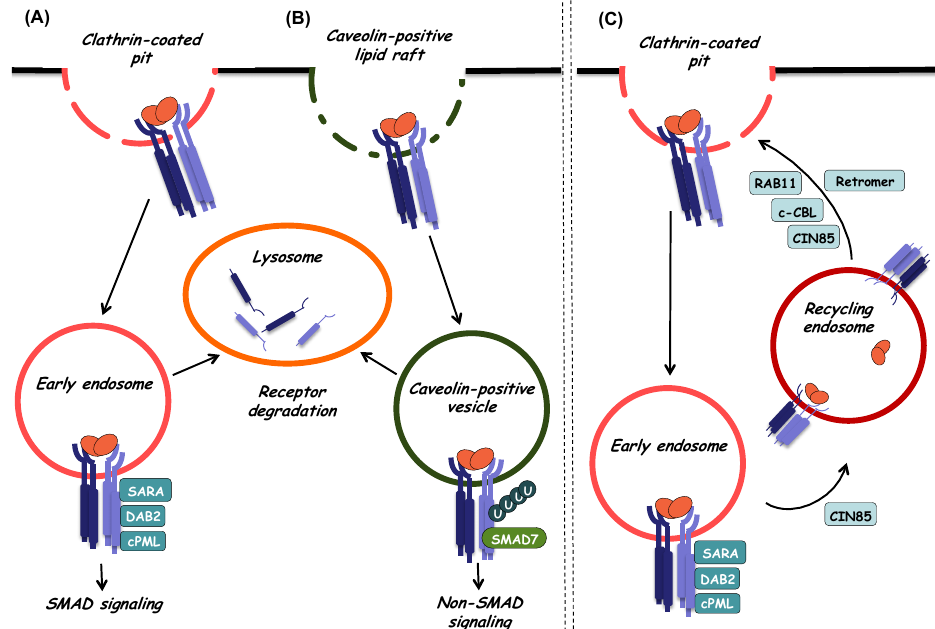
Figure 4. Internalization and intracellular sorting of TGF-β receptors. Endocytosis and intracellular sorting of TGF-β receptors play an important role in the regulation of TGF-β signaling outcome and can be mediated via the two major endocytic pathways. ( A ) SMAD-dependent TGF-β signaling can initiate at the cell surface in clathrin-coated pits. When receptors internalize via clathrin-coated vesicles, they are directed to early endosomes. In these early stages of endocytosis, association of TGF-β receptors with SARA, cPML, and Dab-2 adaptor proteins, leads to the enhancement of TGF-β-induced SMAD activation and subsequent propagation of SMAD-dependent signaling. Internalized TGF-β receptors found in early endosomes can be sorted for degradation. In this case, they enter late endosomes (not shown) and finally reach lysosomes where degradation takes place. ( B ) Internalization of TGF-β receptors can also take place at caveolin-positive lipid raft compartments on the cell membrane, and in this case, internalized receptors enter caveolin-positive vesicles. There, the TGF-β type I receptor preferentially associates with SMAD7, which can control receptor turnover via recruitment of ubiquitin ligases and deubiquitylating enzymes thus regulating ubiquitylation and subsequent lysosomal degradation of receptors. Internalization of TGF-β receptors by lipid raft/caveolar-mediated endocytosis can also promote non-SMAD TGF-β signaling as SMAD7 competes with SMAD2/3 for interaction with the TGF-β type I receptor. ( C ) Once internalized via clathrin-coated pits, TGF-β receptors enter early endosomes. From there, receptors can be sorted to recycling endosomes in order to return back to the cell surface where they can respond again to ligand stimulation. The small GTPase RAB11, the adaptor protein CIN85, the ubiquitin ligase c-CBL and the retromer complex can facilitate recycling in different cell types.